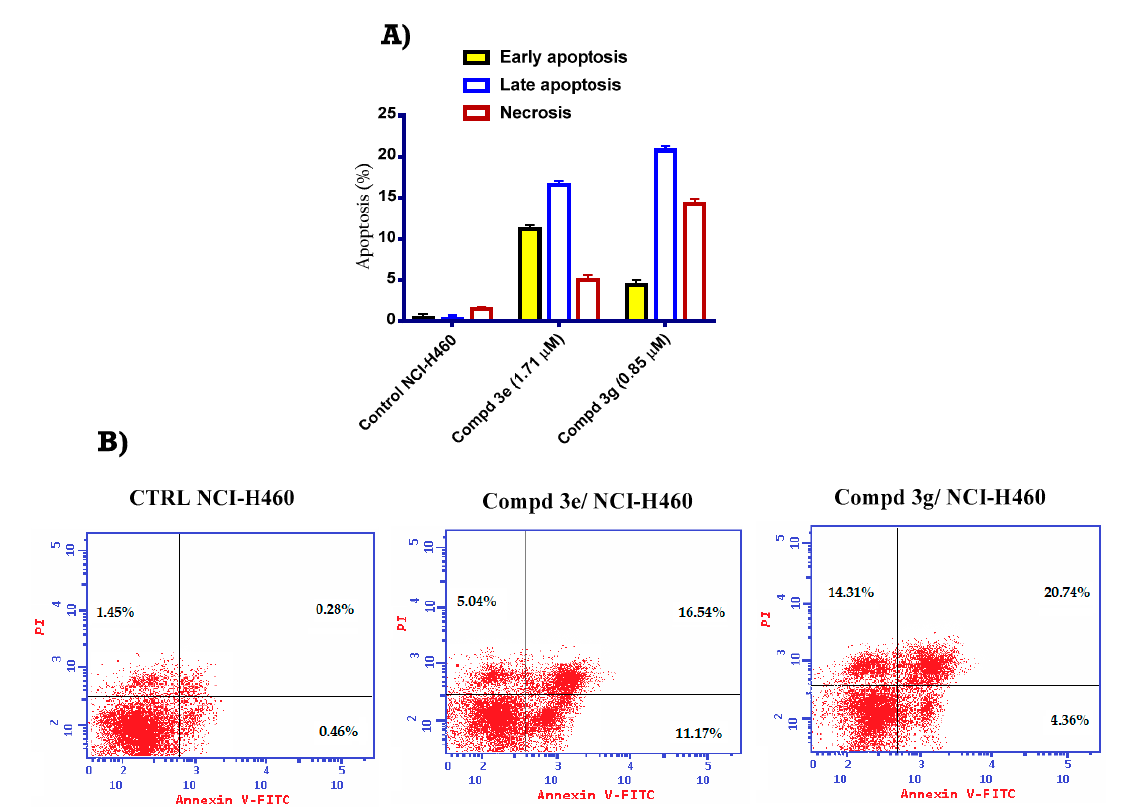
Figure 4. ( A ) Graphical representation of effect of compounds 3e and 3g on induction of apoptosis in NCI-H460 cells after 24 h. ( B ) Effect of compounds 3e and 3g on induction of apoptosis in NCI-H460 cells after 24 h.